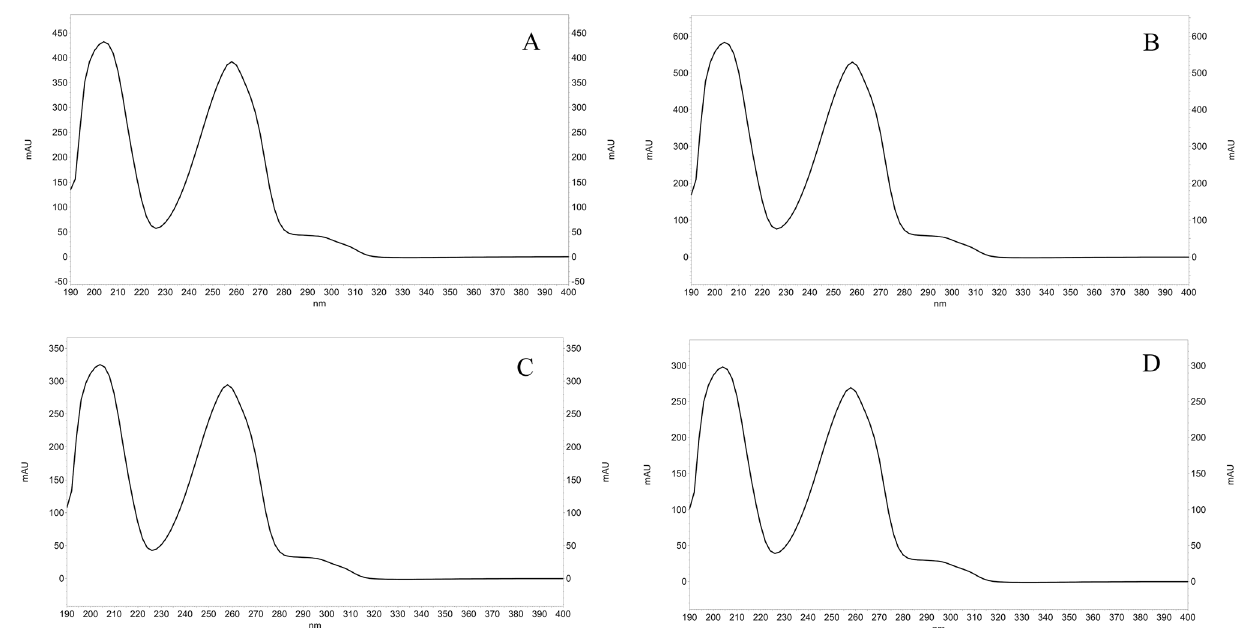
peak regions of the peak of trans -anethole in C. anisata leaf extract and the UV spectrum of the peak of standard trans -anethole was observed